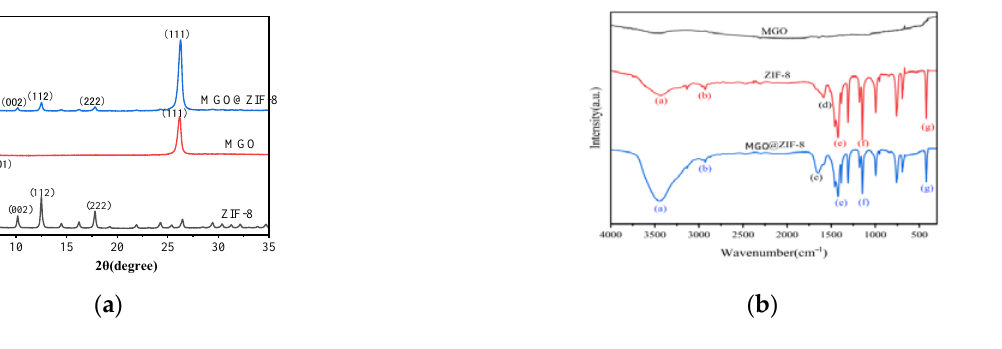
Figure 4. ( a ) XRD patterns of the samples; ( b ) FT-IR spectra analysis.